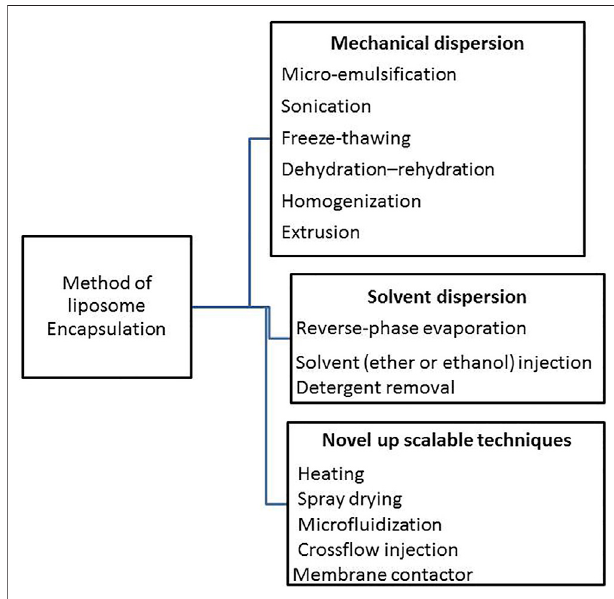
FIGURE 1 | Scheme en listed the main methods applied for encapsulation on colloidal/vesicular systems.